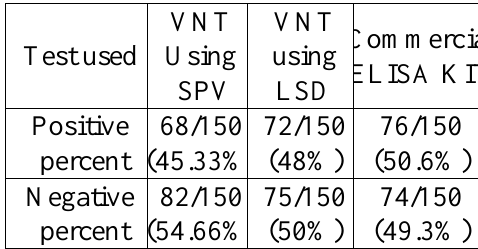
Table 3: Summary of comparative mean reactivity of LSD vaccinated bovine sera and Serum dilution Vaccinated calves’ serum samples